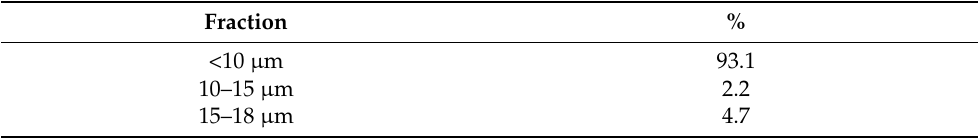
Table 3. Activated charcoal particle size distribution.